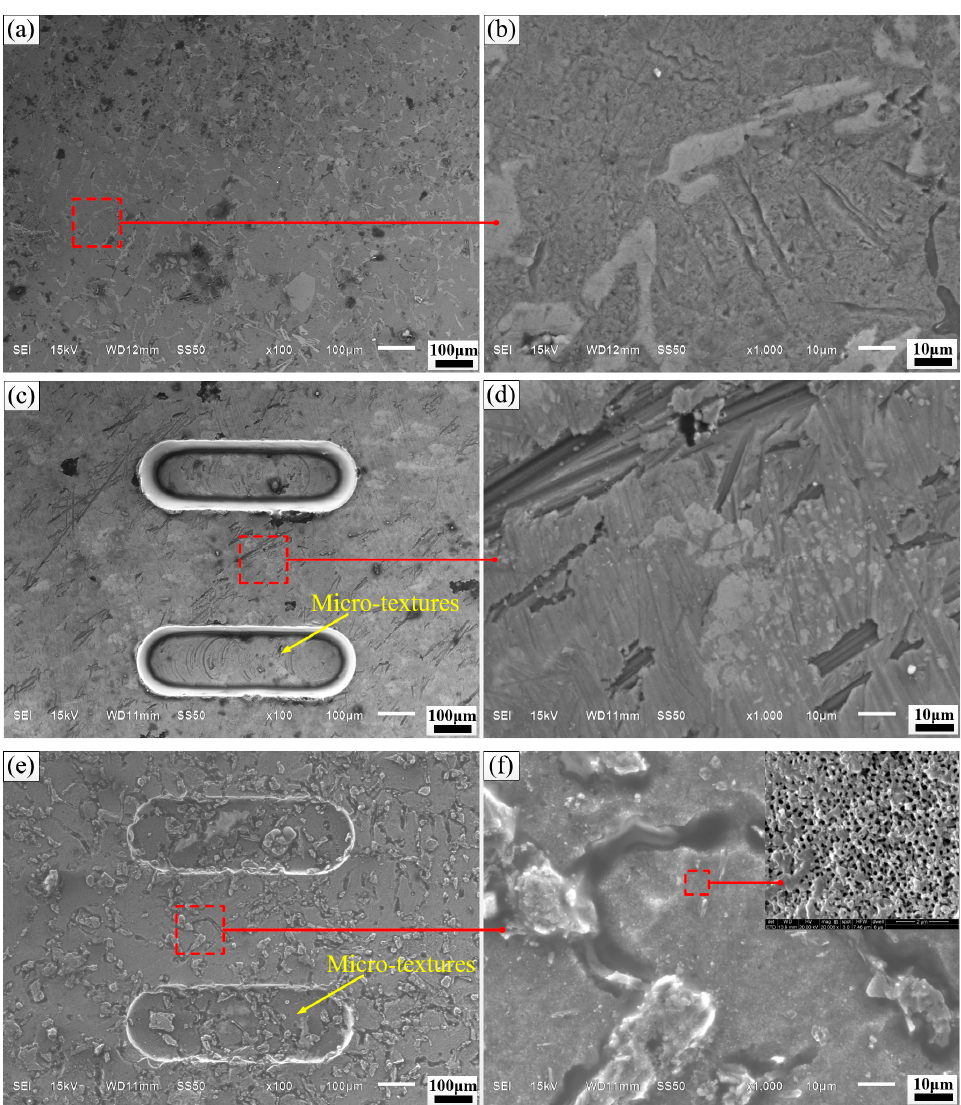
SEM and enlarged morphology of ( a , b ) flat; ( c , d ) micro-textured; ( e , f ) anodizing micro-textured specimens.